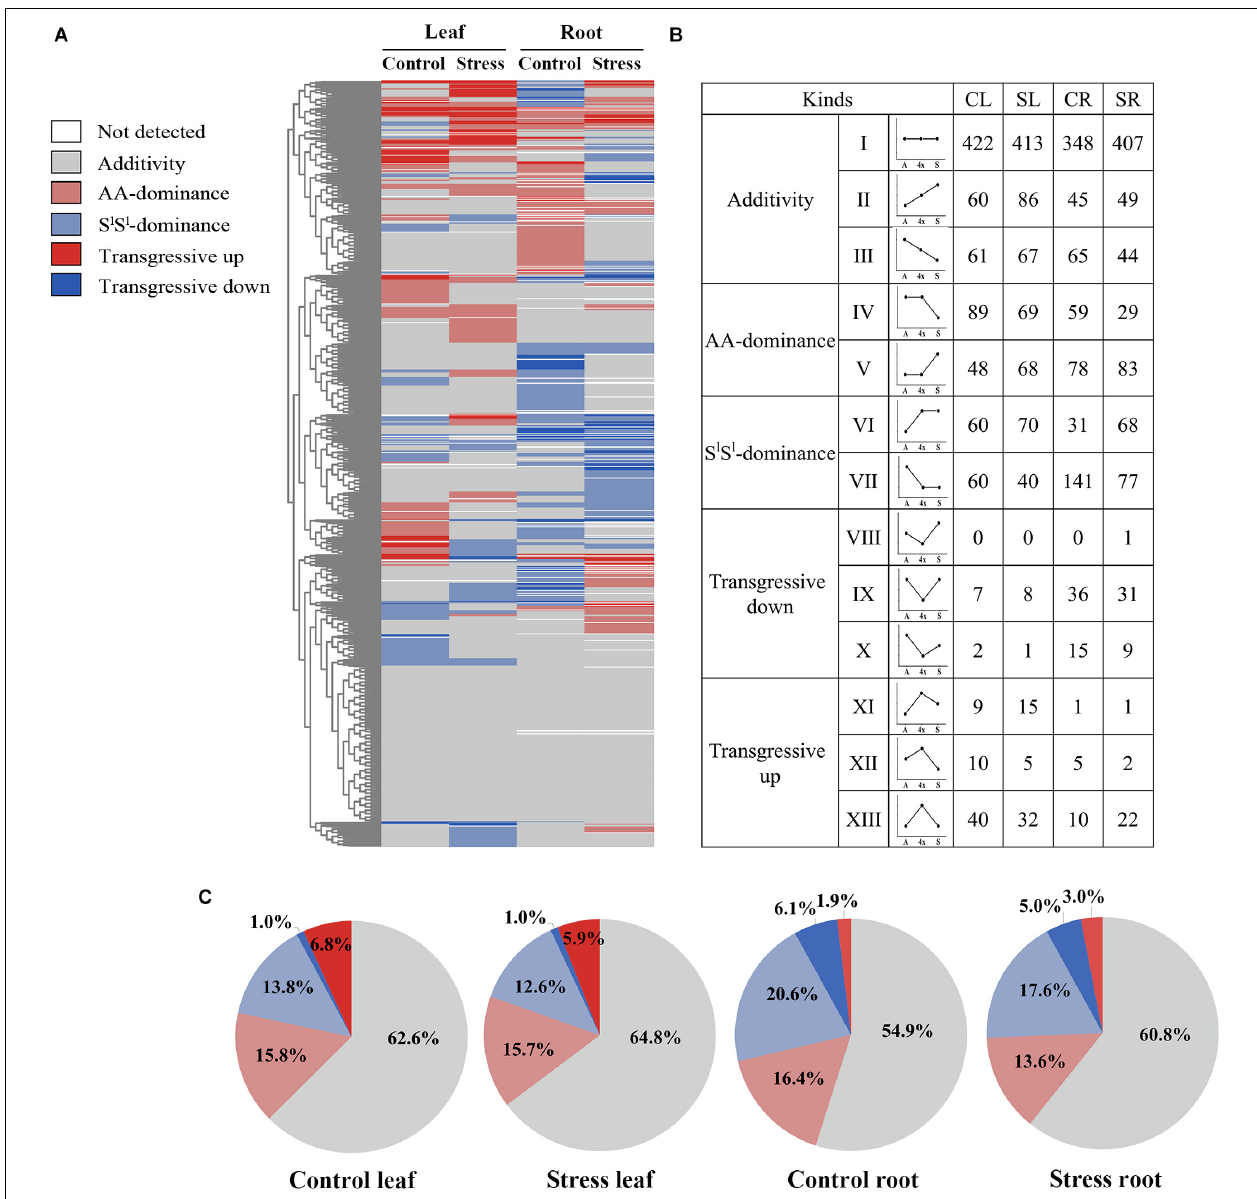
FIGURE 5 | Summary of non-additive and additive accumulation of metabolite in the synthetic tetraploid wheat line under control and salinity stress condition. (A) Heat map showing non-additive and additive assignation of each detected metabolite; (B) number of metabolites of additive accumulation and each non-additive accumulation type; (C) the pie diagrams showing metabolite proportion among different non-additive accumulation types. The seedlings were exposed to 150 mM NaCl for 7 days. CL, control leaf; SL, stress leaf; CR, control root; SR, stress